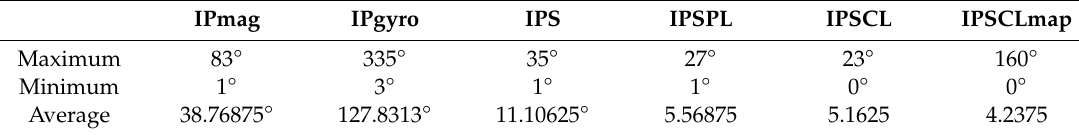
Table 2. Maximum, minimum, and average distance error of techniques.